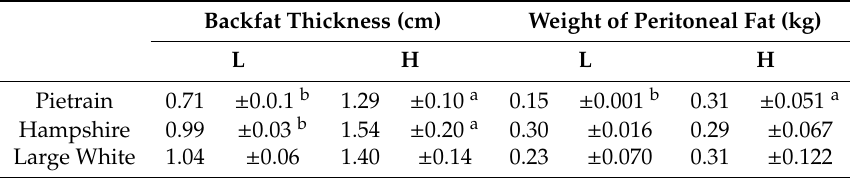
Table 1. The di ff erences in fatness traits detected in all three breeds and obtained pig groups used in genetic analyses. Backfat Thickness (cm) Weight of Peritoneal Fat (kg) L H L H Pietrain 0.71 ± 0.0.1 b 1.29 ± 0.10 a 0.15 ± 0.001 b 0.31 ± 0.051 a Hampshire 0.99 ± 0.03 b 1.54 ± 0.20 a 0.30 ± 0.016 0.29 ± 0.067 Large White 1.04 ± 0.06 1.40 ± 0.14 0.23 ± 0.070 0.31 ±